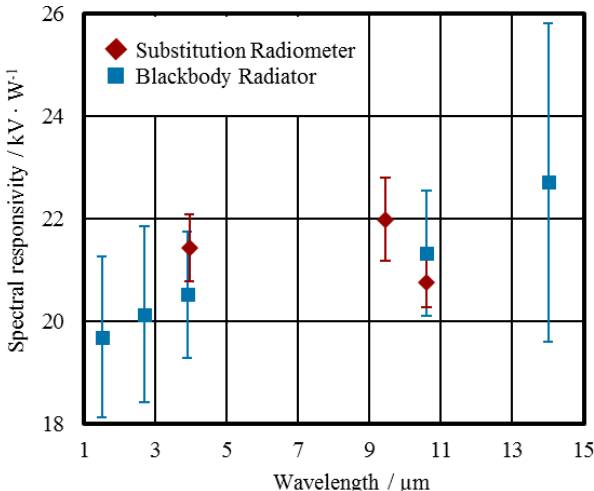
Figure 8. The spectral responsivity of a pyroelectric detector mea- sured at the cryogenic electrical substitution radiometer facility (red) and the blackbody radiator facility with optical bandpass fil- ters (blue). The error bars indicate the standard measurement uncer-